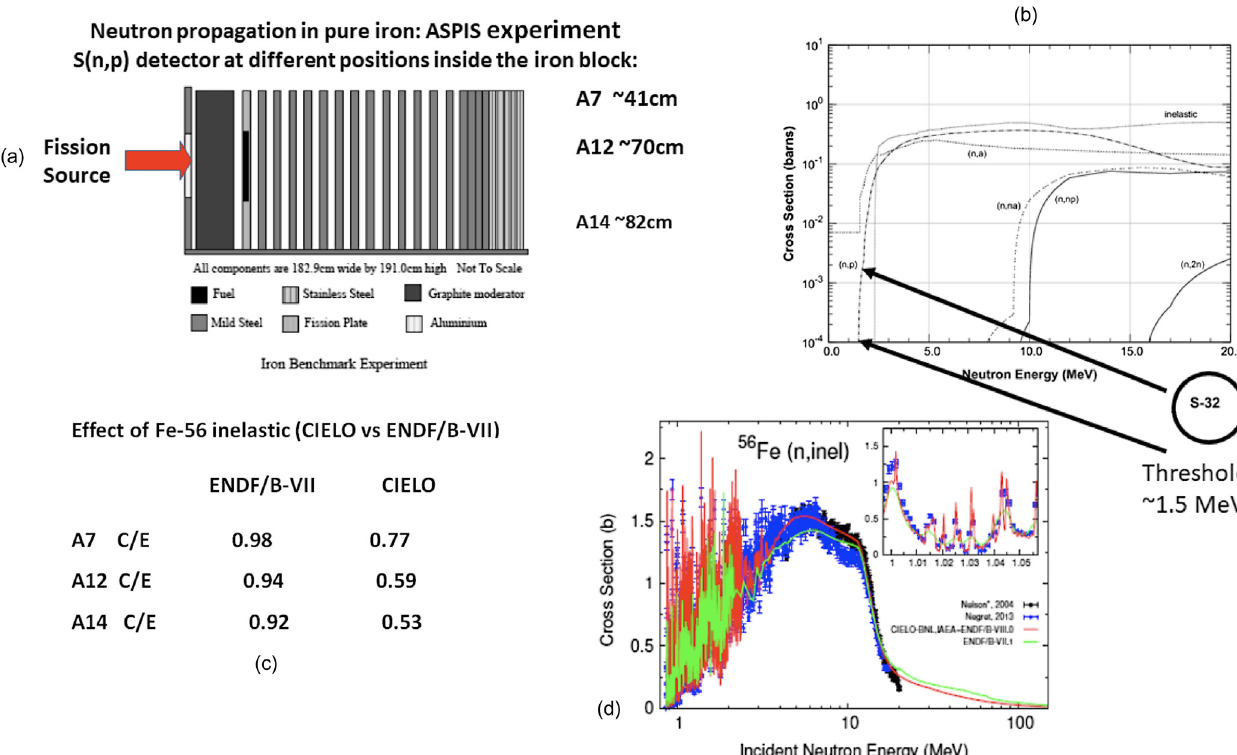
Fig. 1. 56 Fe (n,n ’ ) reaction evaluation and validation: (a) The ASPIS neutron propagation experiment; (b) the S(n,p) reaction; (c) C/E values for the S(n,p) detector at different positions, using both ENDF/B-VIIand CIELOevaluations; (d) the CIELO56 Fe(n,n ’ )